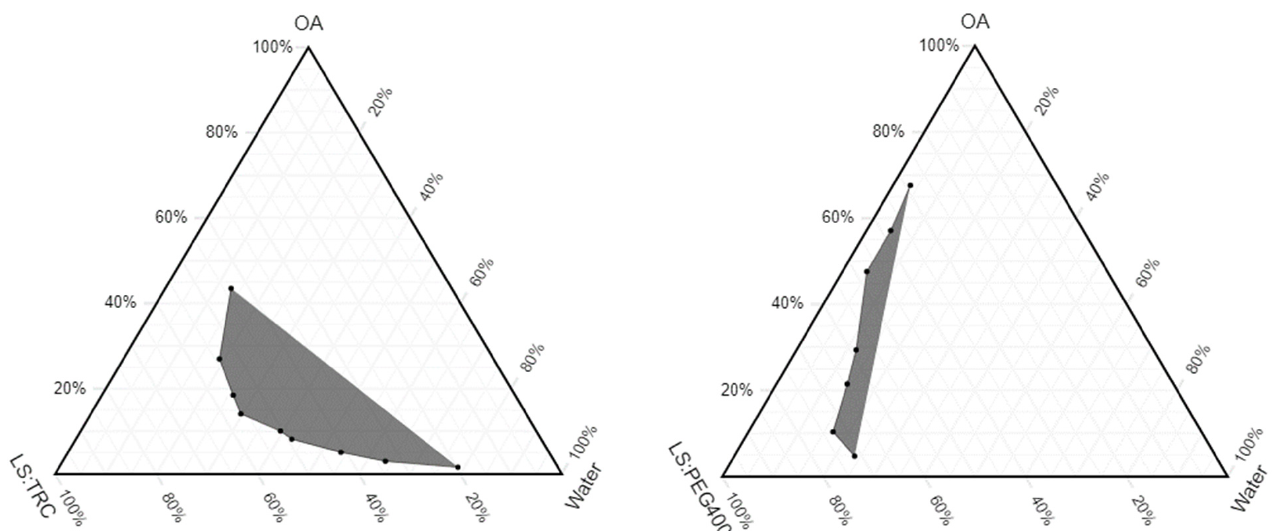
Figure 7. Pseudoternary phase diagrams of microemulsions formulated using oil (cin and OA), surfactant (T80 and LS), co-surfactant (PEG 400 and TRC), and water. Surfactant to co-surfactant ratio is 1:1.